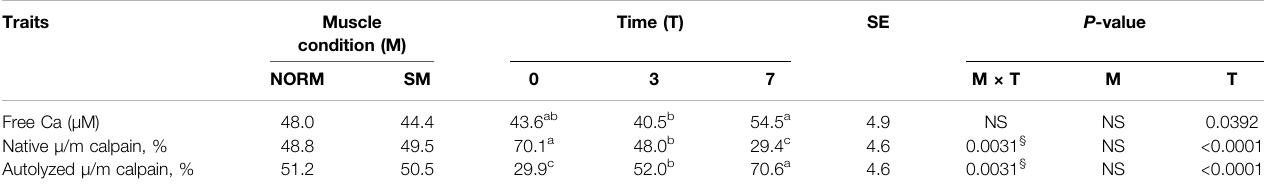
TABLE 2 | Free calcium content and calpain activity of broiler breast meat according to muscle condition (M — normal, NORM; Spaghetti Meat, SM) and postmortem time (T — 0, 3, 7 days). Traits Muscle condition (M)